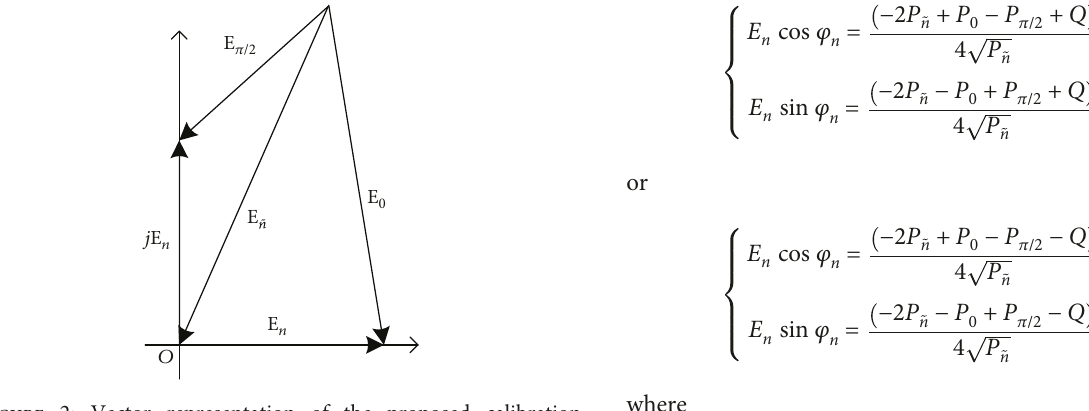
Figure 2: Vector representation of the proposed calibration